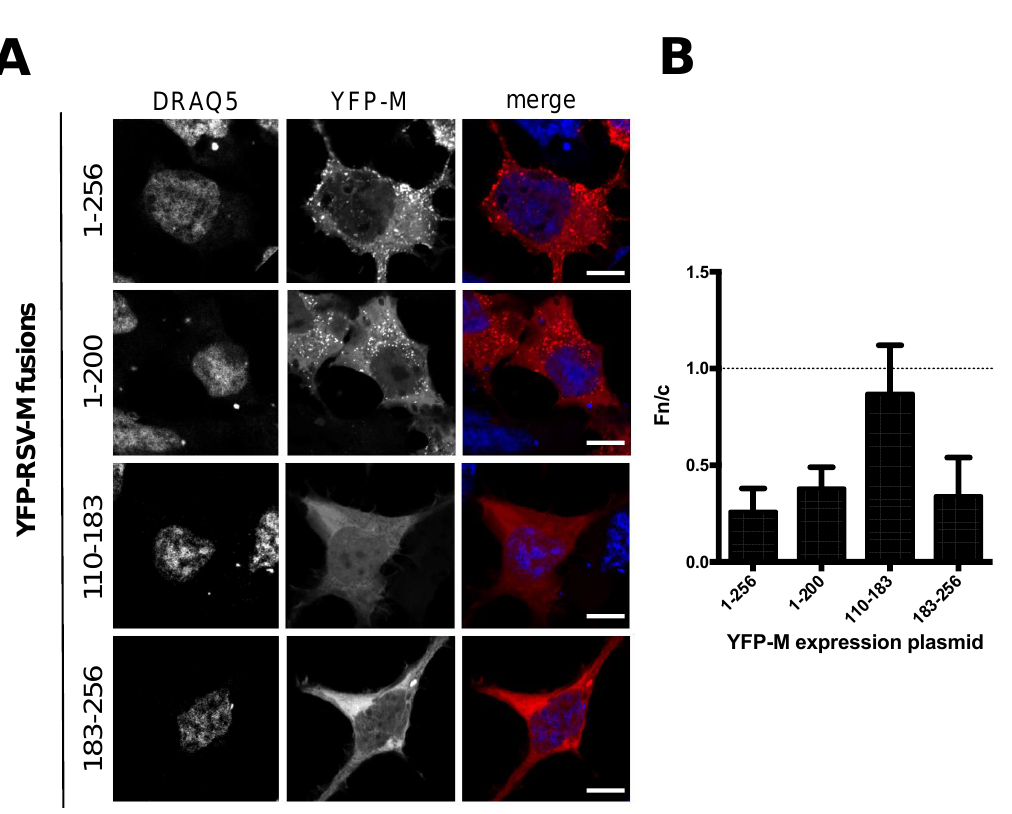
Figure 2. Deletion of N- and C-terminal portions of RSV M affects protein subcellular localization. ( A ) HEK293 A cells were transfected to transiently express the indicated YFP-M fusions. 24 h post transfection cell nuclei were stained with DRAQ5, and samples processed for confocal laser scanning microscopy (CSLM) analysis. Representative images relative to cell nuclei (DRAQ5) and M fusions (YFP-M) are shown on the left and middle panels, respectively. Merged images of the two channels are shown in the right panels. Scale bars represent 20 µ M. ( B ) Digital images such as those shown in ( A ) were quantitatively analyzed using software ImageJ to calculate the Fn/c ratio relative to each fusion protein, as described in Material and Method section. The mean ± SD relative to at least 75 cells from 2 independent experiments is shown. The dotted line represents Fn/c of 1, corresponding to an even distribution between the nucleus and the